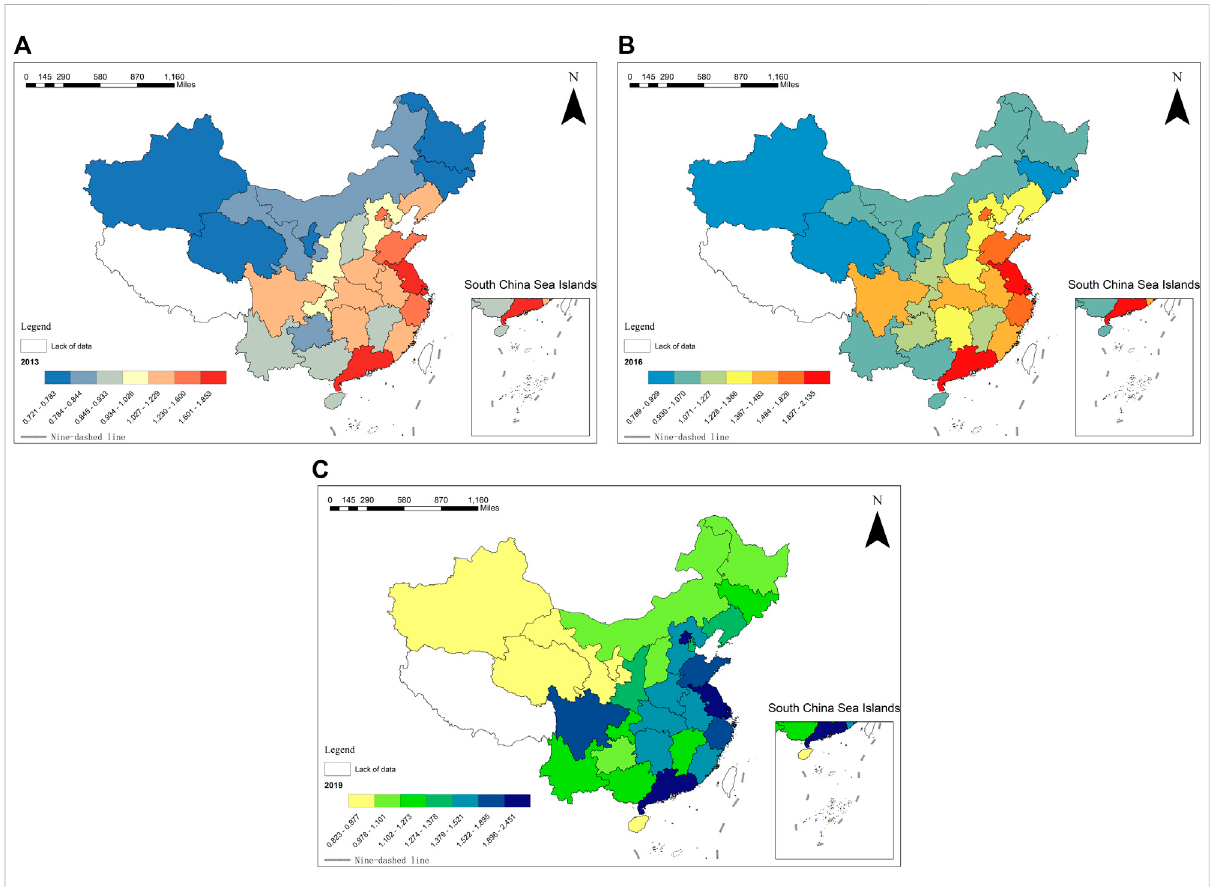
FIGURE 4 Digital economy development in 30 provinces and regions in China, 2013 (A) , 2016 (B) and 2019 (C)